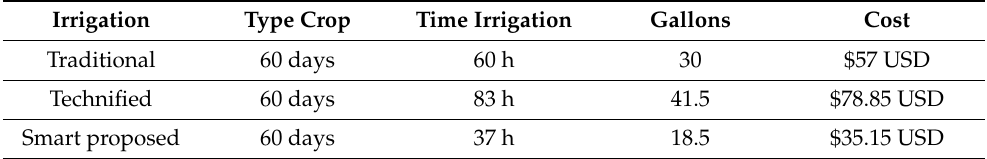
Table 7. Cost of generation Scenario